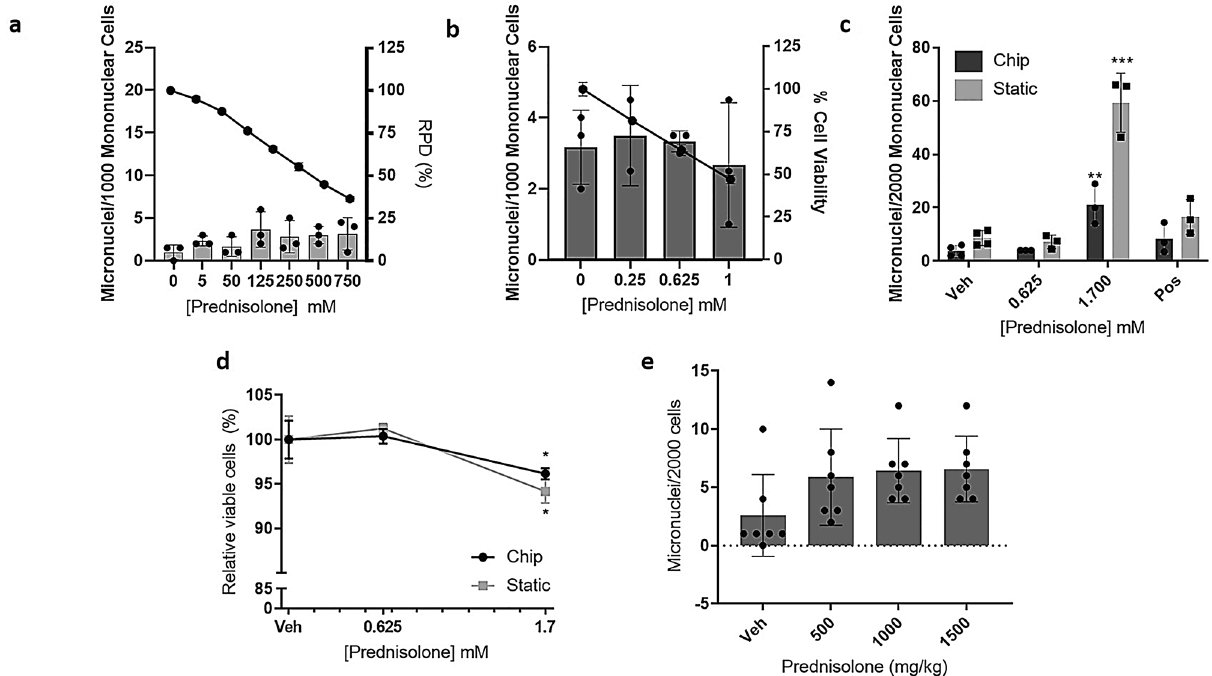
Figure 5. 3D bone marrow (BM) models detect micronuclei (MN) after treatment with prednisolone. ( a ) MN and cytotoxicity were measured in the in vitro L5178Y MN assay. Data are presented as MN/1000 mononuclear cells (bars) and lie within the historical vehicle-treated control for the laboratory (indicated by the dashed lines; 2.85 ± 2.26). Cytotoxicity is presented as the RPD (line). ( b ) MN and cytotoxicity were measured in the 2D BM assay. Data are presented as MN/1000 mononuclear cells (bars) and cytotoxicity as percentage cell viability (line). ( c ) MN following treatment of 3D BM models with 0–1.7 mM prednisolone. Data are presented as MN/2000 mononuclear cells. ( d ) Cytotoxicity of cells from the 3D BM models was measured by flow cytometry 7-AAD + staining, identifying dead cells. Data are presented as the percentage of relative live cells. ( e ) Previously acquired in vivo data (MN/2000 cells following treatment of rats with 0–1500 mg/kg prednisolone). 2D and 3D conditions: n = 3 ( n = 2 for 0.25 µM prednisolone in 2D BM cells). In vivo groups: n = 7. Data (except ( e )) are presented as mean ± SD. Significance compared to vehicle control (one-way ANOVA with Dunnett’s post-test (** p < 0.01; *** p < 0.001; **** p <